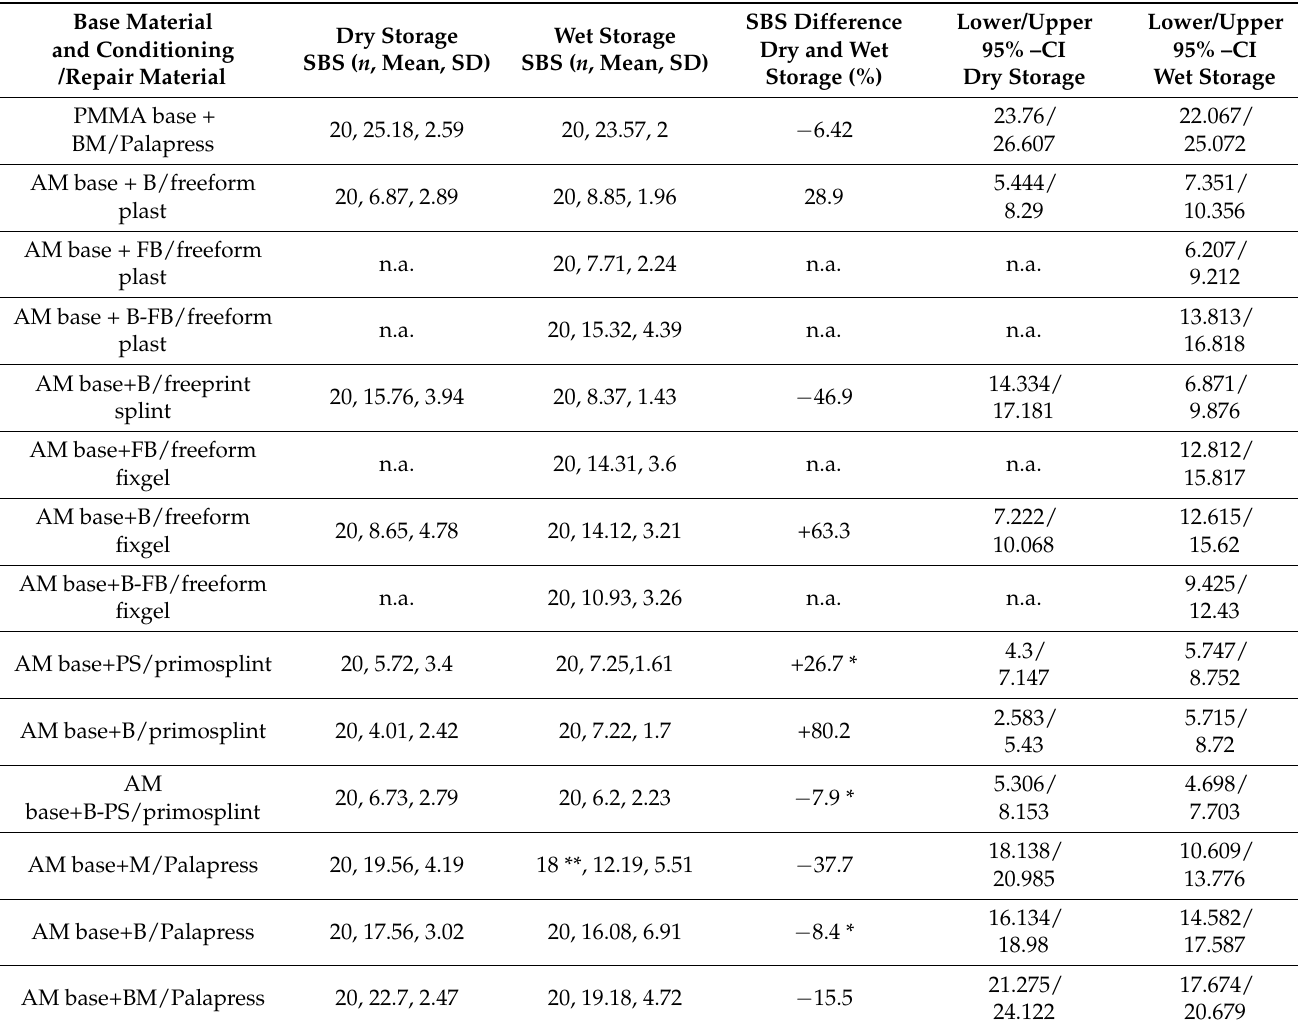
Table A1. SBS values of the tested specimens. (n.a. indicated groups not tested due to the study